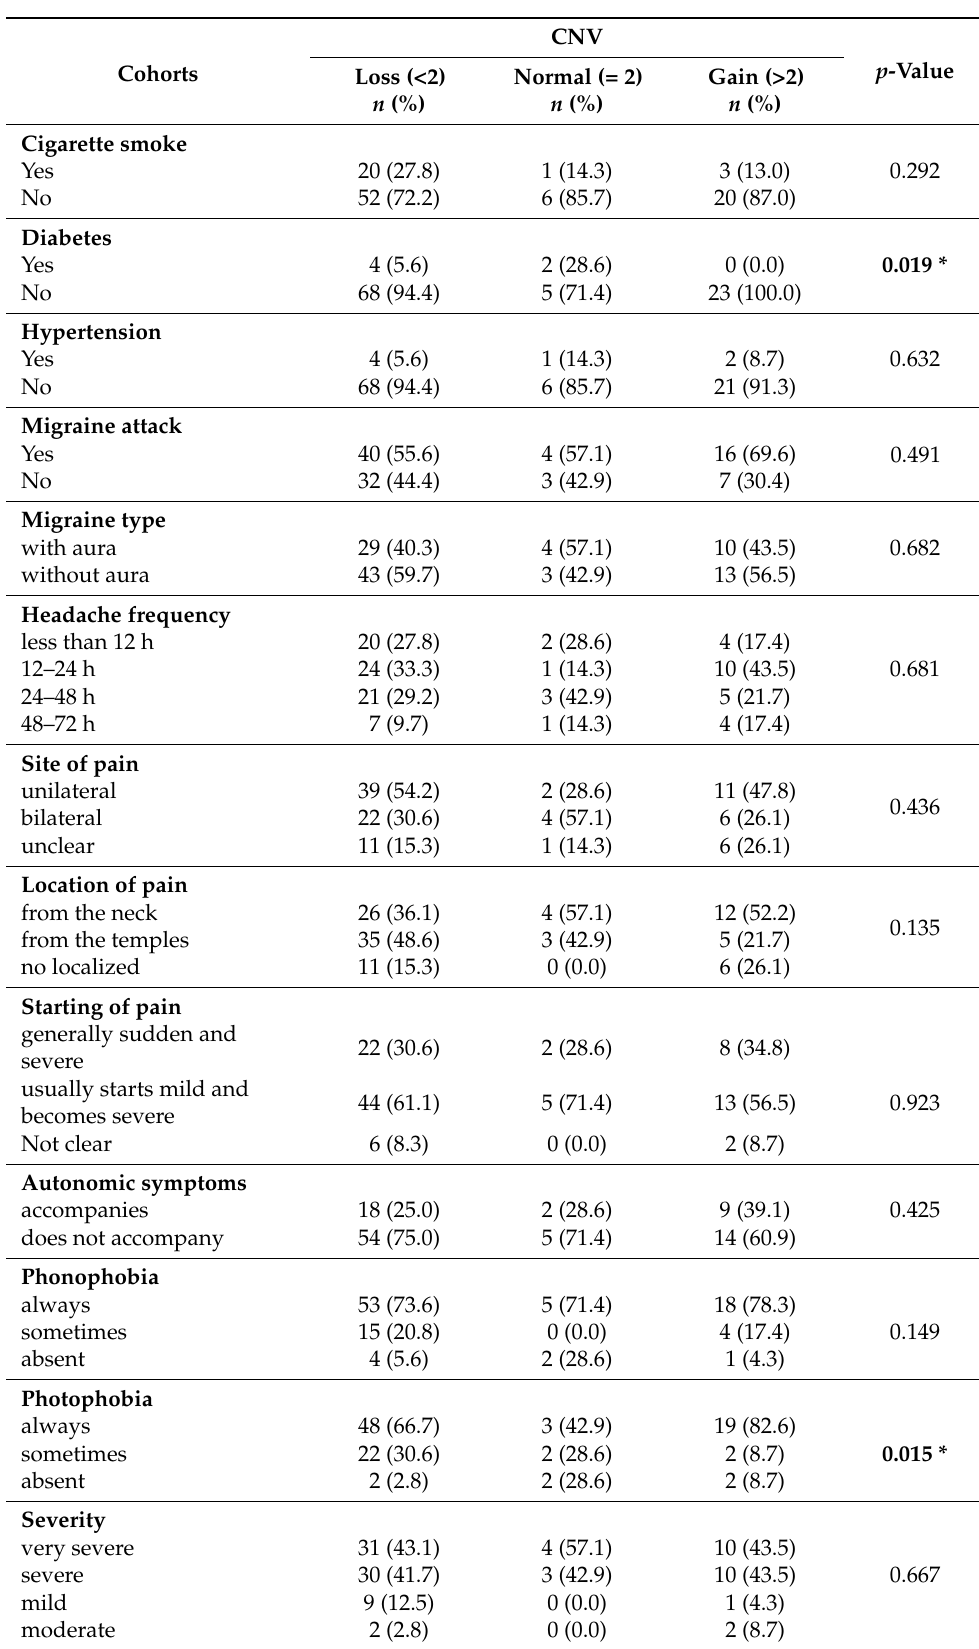
Table 7. Evaluation of clinical variables and measurements of CHRNA7 gene